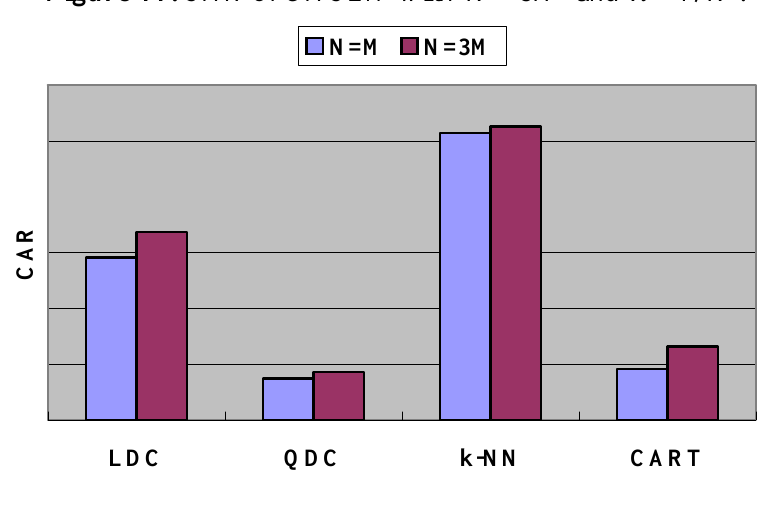
Figure 11. CAR of GACEM with